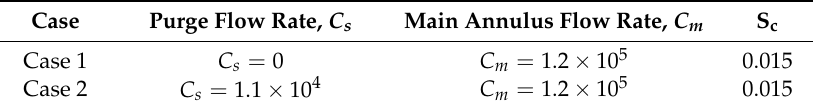
Figure 1. Schematic of the experimental system. Particle image velocimetry (PIV). Table 1. Operating condition of the research turbine.